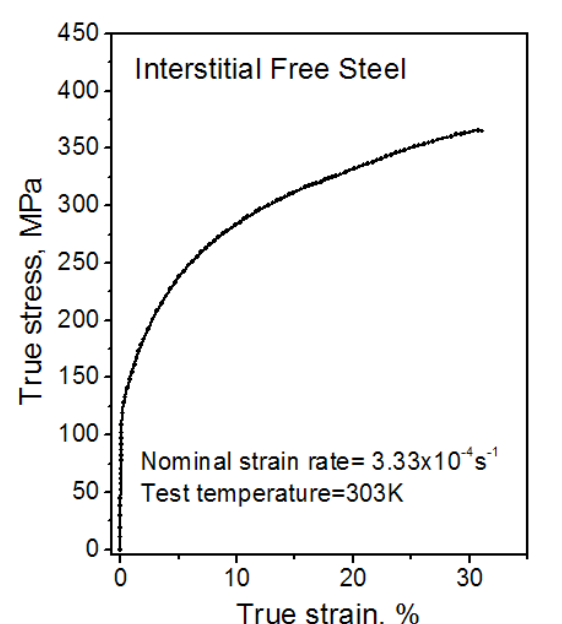
Figure 2: True stress vs . true strain curve for investigated IF steel. Figure 3: Typical plot of the variations of microhardness